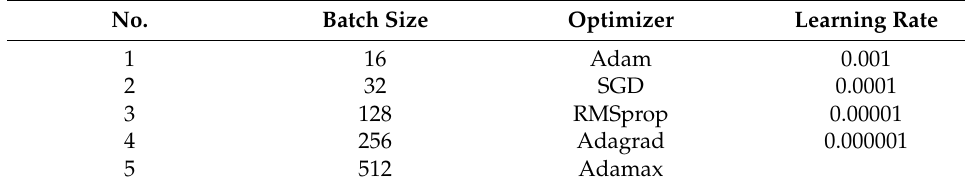
Table 5. Search space settings.